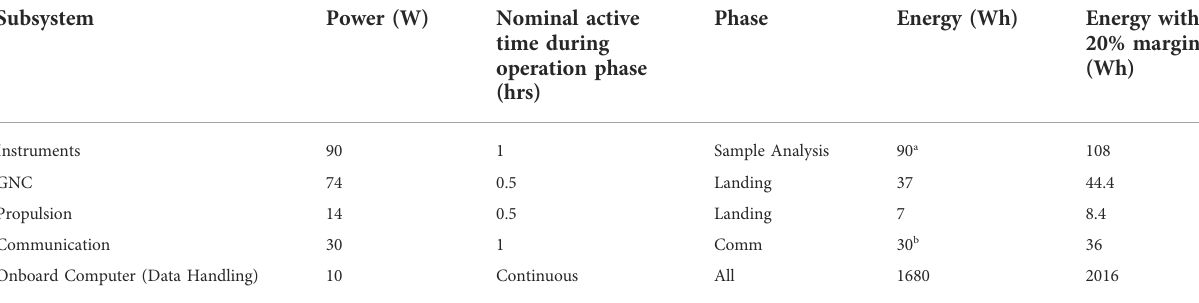
TABLE 5 Power budget for the lander. The lander operates the GNC and propulsion system during the descent and landing phase of 30 min. Lander instruments analyze the collected sample over a period of 1 h during the sample analysis phase. The communication system communicates for 1 hwiththeorbiterduringthecommunicationphasewhichhappenseveryorbiterpassage(every13.3 h).Theonboardcomputerworkscontinuously for the overall lander operations in all phases.